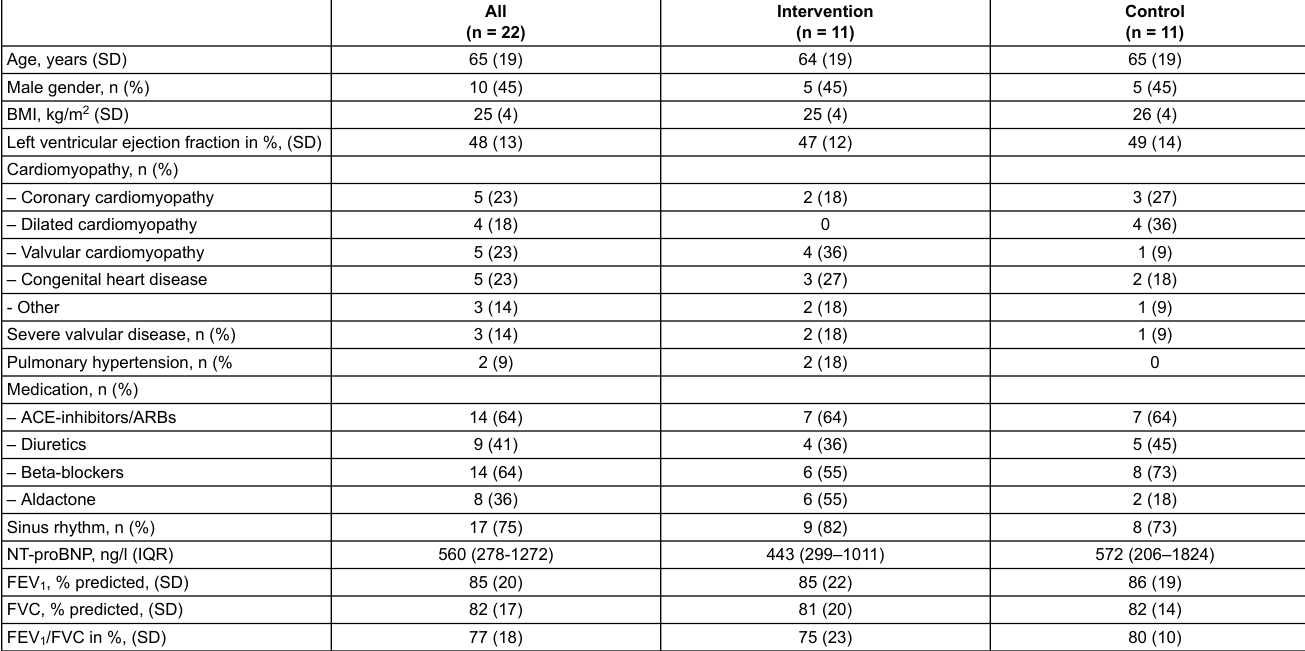
Table 1: Baseline